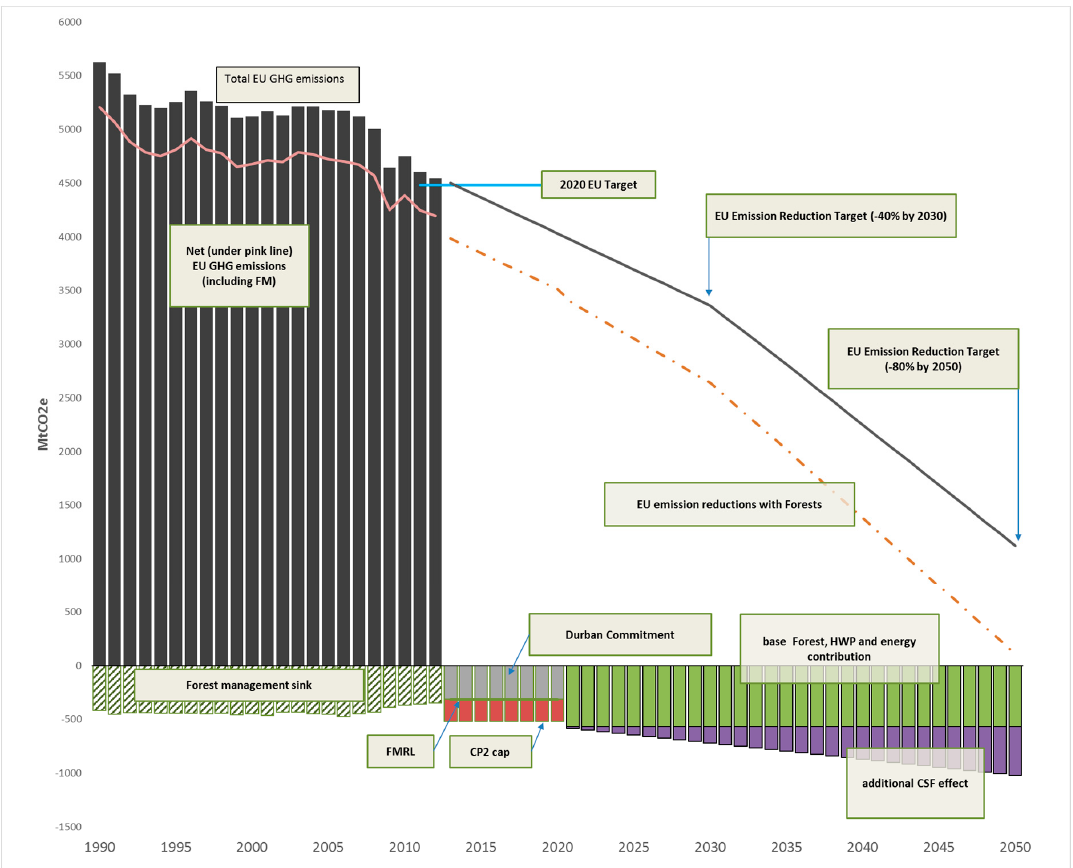
Figure 1. Total Projected European Union (EU) Emission Reductions by 2050, with and without climate Smart Forestry. Reported data were used through to 2012 (emissions of all sectors positive and sinks negative). The expected impact of both the Durban commitment created by the introduction of the Forest Management Reference Level (FMRL), and the cap for the second Commitment Period (CP2 cap), through 2020 is projected by the red and grey bars. Further, we project the potential forest contribution from climate smart forestry from 2020 to 2050 through bright green and purple bars. These consist of forest (net removals), harvested wood products and bio-energy. The green bars provide the projected base forest contribution from 2020 to 2050. The purple bars are the additional Climate Smart Forestry (CSF) effect based on the potential introduction of additional incentives as described in this article. These total potential contributions from CSF forestry on net EU emissions (displayed as negative bars) is then copied by the brown and purple line and suggests a significant impact compared to the EU’s current 80% emission reduction target by 2050. GHG: Greenhouse gases;